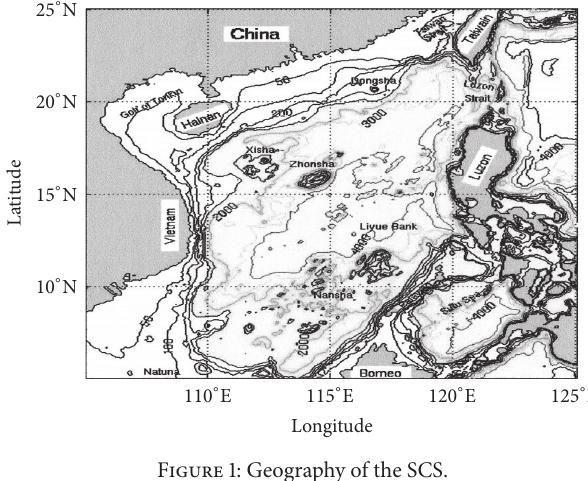
Figure 1: Geography of the SCS.